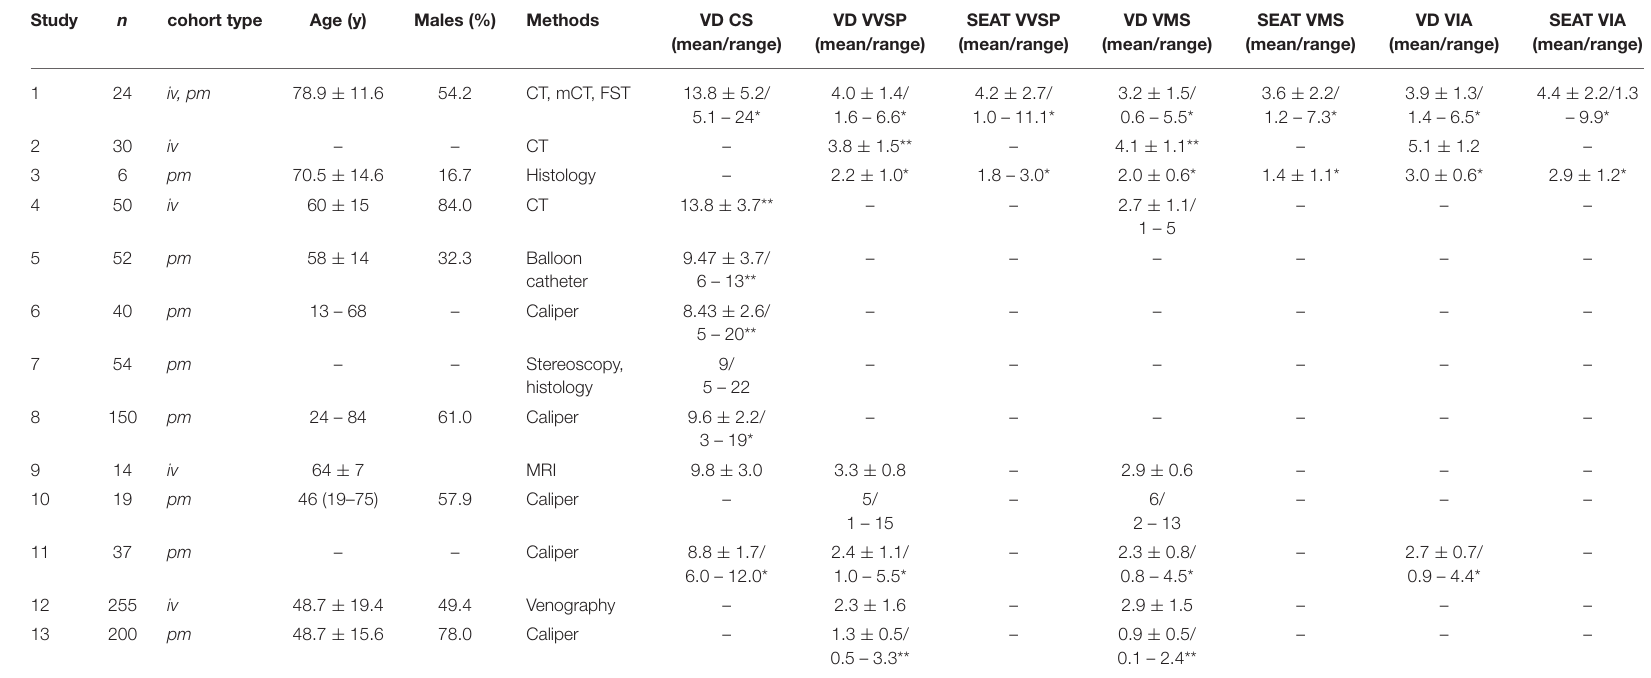
TABLE 1 | Morphometric studies on human coronary vein